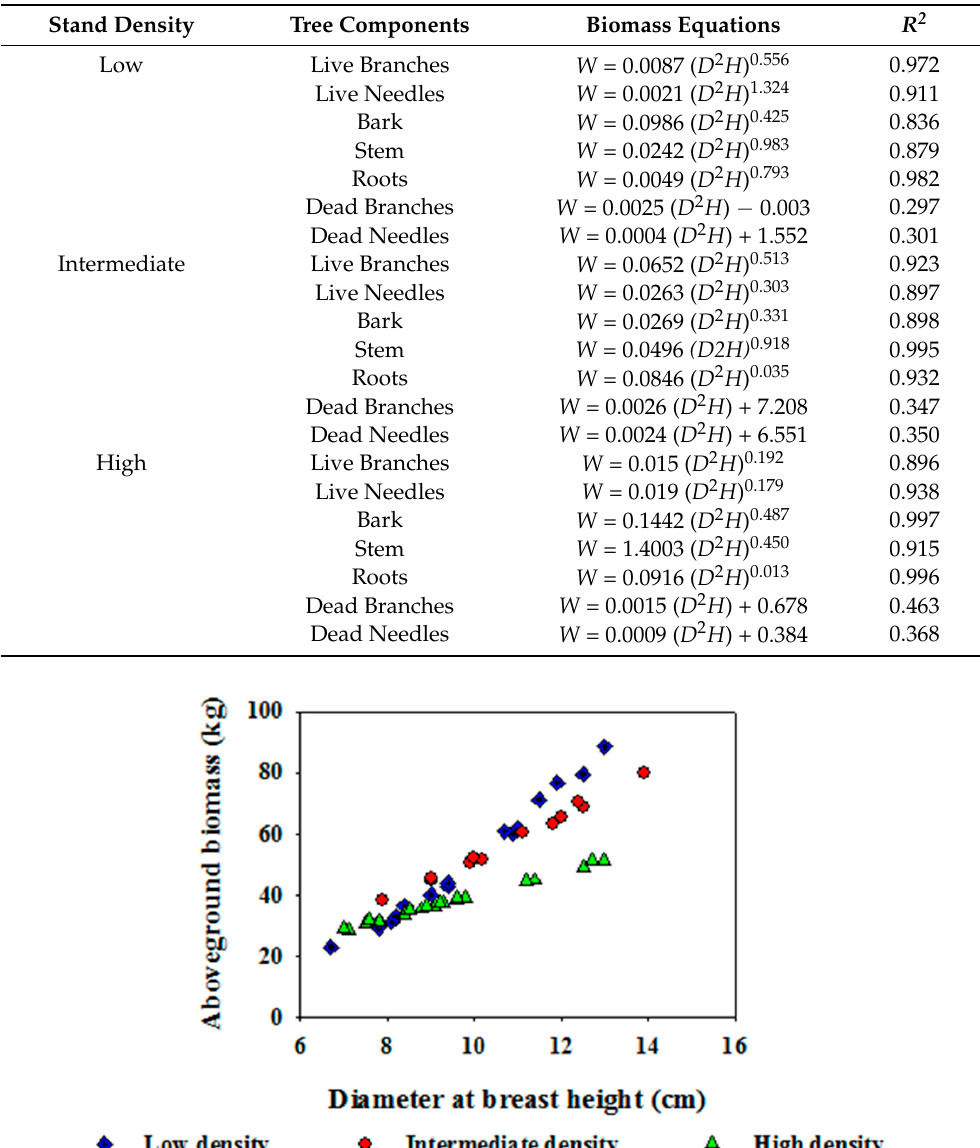
Figure 4. Relationship between aboveground biomass and diameter at breast height of Chinese fir trees from different stand density levels at a specified total tree height (10–11 m).